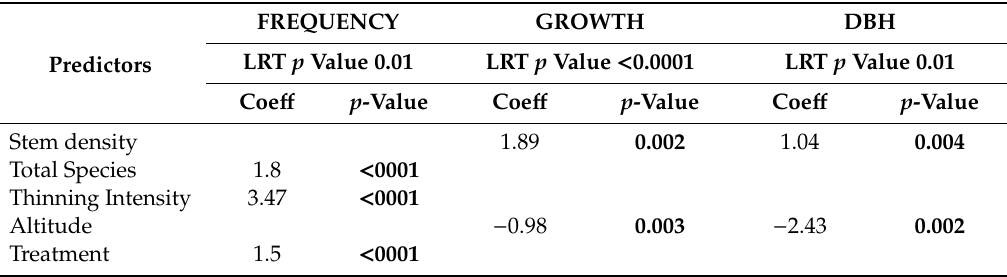
Table 4. Linear mixed models (LMM) of Community weighted mean CWM of potential crop trees frequency (FREQUENCY), diametric growth (GROWTH) and initial diameter at breast height (DBH) as a function of stem density (trees ha − 1 ), total species, thinning intensity, altitude, treatment, and